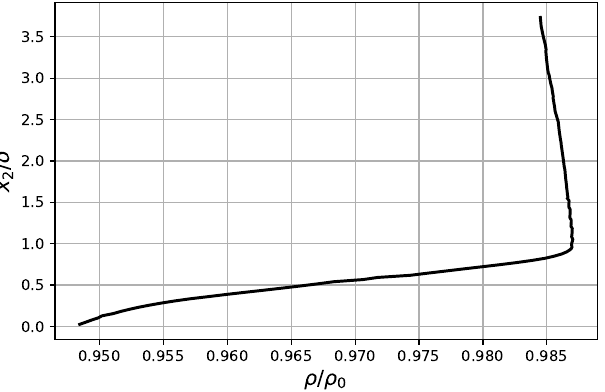
Figure 5. Normal-to-wall mean density profile at pressure sensor